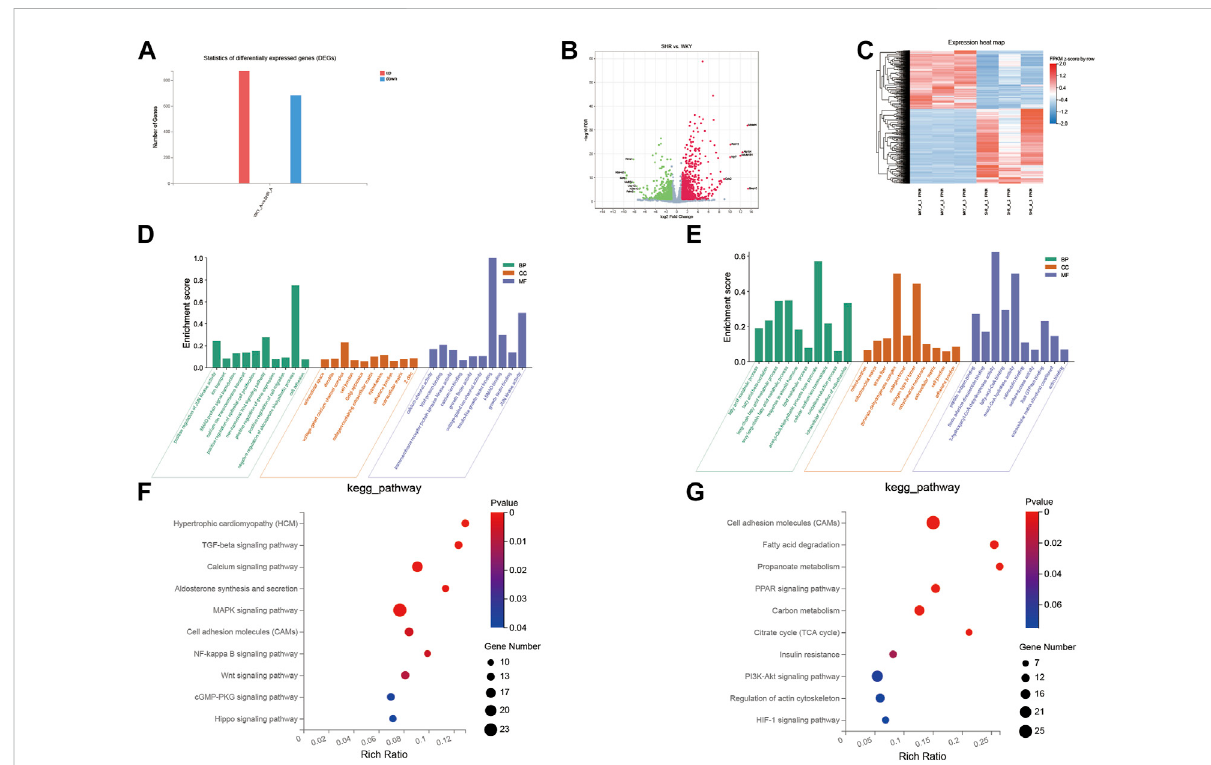
FIGURE 4 GO and KEGG pathway analysis of DEGs between SHR and WKY rat left atrium. (A) Histogram of the numbers of DEGs: the abscissa represents the direction of gene change, the ordinate represents the number of genes, red represents up-regulation, blue represents down-regulation; (B) volcano Plot: X -axis represents the fold change of log2, Y -axis represents − log10 ( p -value), red represents up-regulated genes, blue represents down-regulated genes, and gray represents insigni fi cant genes; (C) heatmap: X -axis represents different groups of rats, Y -axis represents differentgenes,redrepresentsup-regulatedgenes,bluerepresents down-regulatedgenes. (D,E) TenGO enriched termsintheupregulated (D) and downregulated (E) DEGs, were analyzed for biological process (BP), cellular component (CC), and molecular function (MF). The X -axis shows differentpathways,andthe Y -axisshowsenrichmentscores,BPingreen,CCinorange,andMFinblue. (F,G) 10KEGGpathwayswereidenti fi edinthe downregulated (F) and upregulated (G) DEGs. The X -axis represents the enrichment ratio, the Y -axis represents thedifferentpathwaysenriched, the size of the dots represents the number of genes enrichedto the pathway, and thechange of color from blueto red represents the change of p value from small to large. GO, gene ontology; KEGG, Kyoto Encyclopedia of Genes and Genomes. TGF-beta, transforming growth factor beta; MAPK, mitogen-activated protein kinase; PPAR, peroxisome proliferator-activated receptor; TCA, tricarboxylic acid; HIF-1, hypoxia-inducible